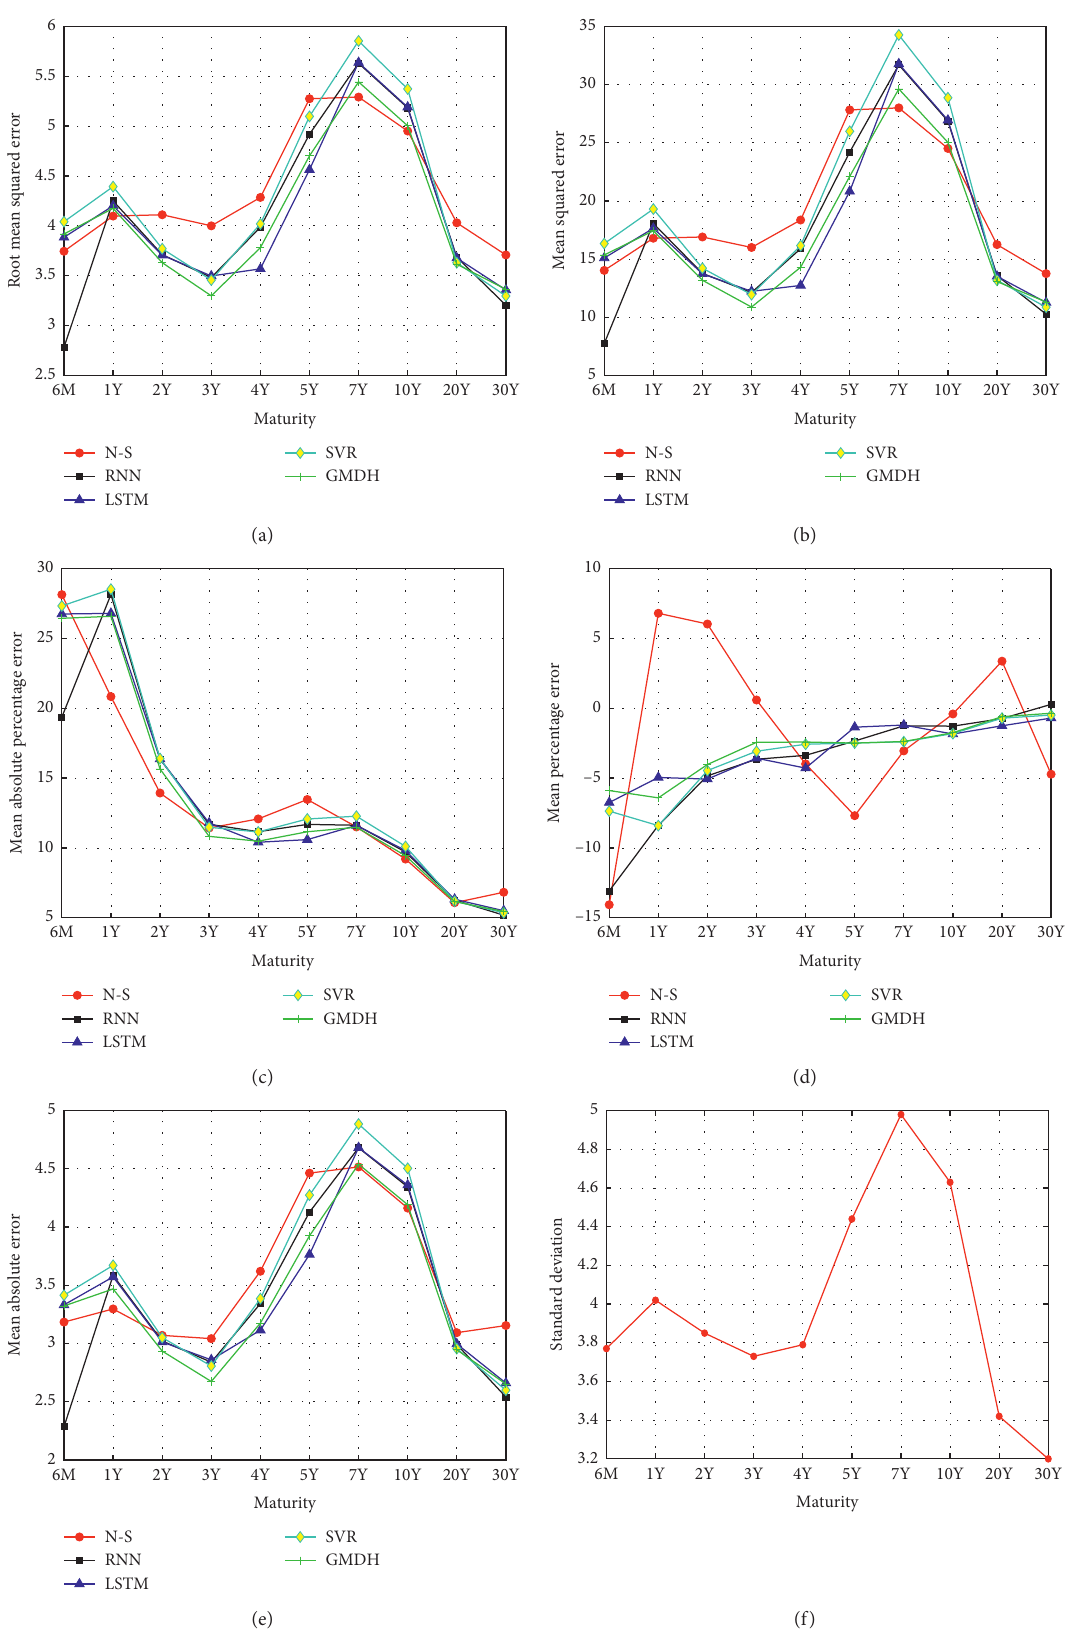
Figure 13: Error of each method for all maturities from Table 7 and standard deviations for all maturities (case 2): (a) RMSE (subperiod 1 training set); (b) MSE (subperiod 1 training set); (c) MAPE (subperiod 1 training set); (d) MPE (subperiod 1 training set); (e) MAE (subperiod 1 training set); (f) test dataset